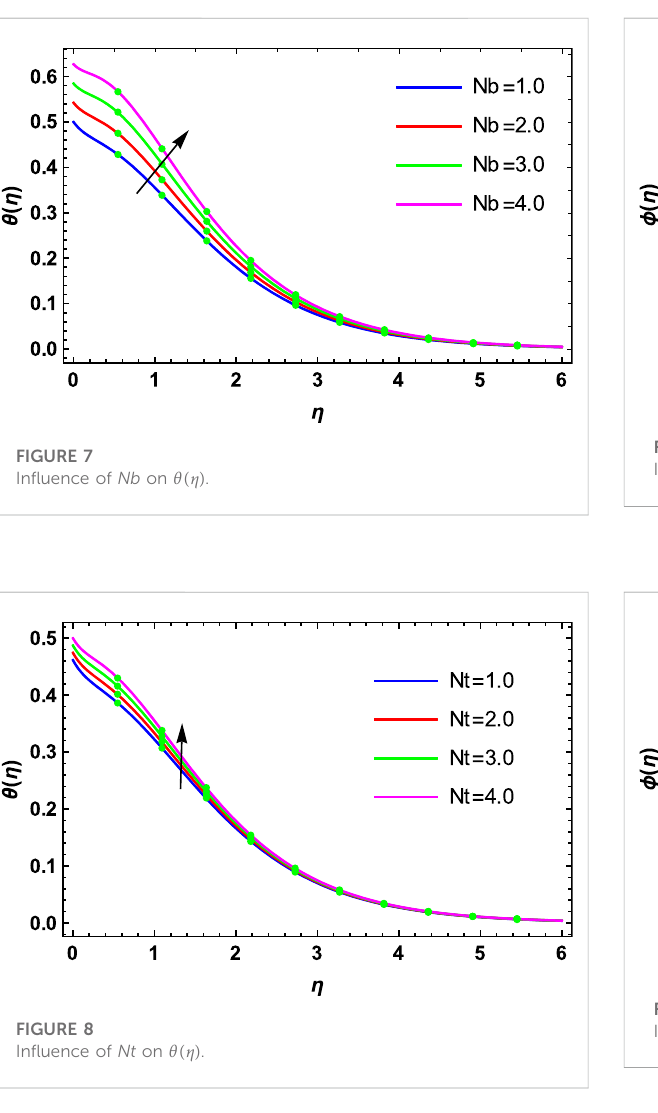
In fl uence of Nt on ϕ ( η ) .